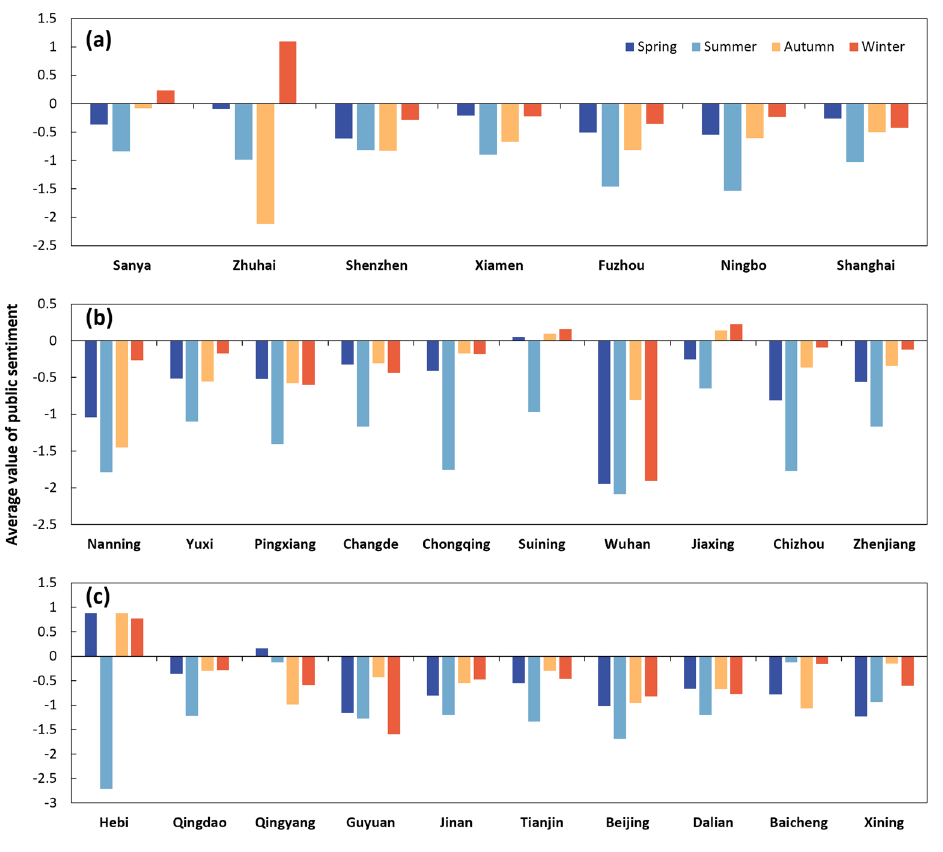
Figure 6. Average seasonal value of public sentiment to urban flood in coastal rainy or humid cities ( a ), inland humid cities ( b ), and semi-arid cities ( c ).